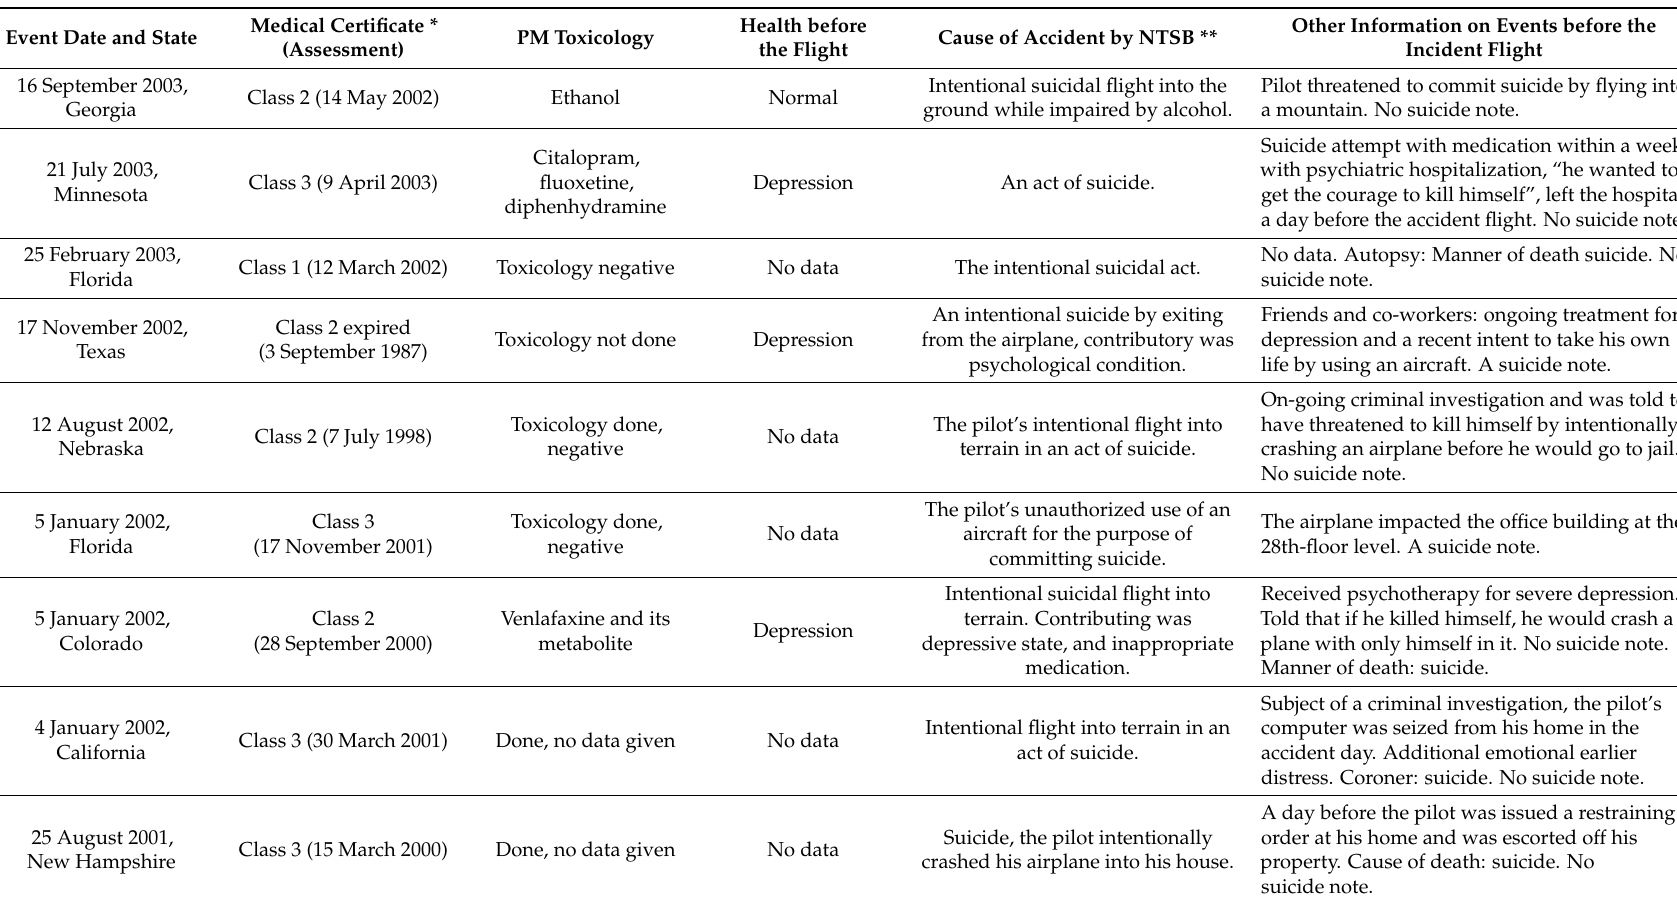
Table 2. Aircraft-assisted pilot suicides in the National Transportation Safety Board database five years before and three years after the 11 September 2001. Event Date and